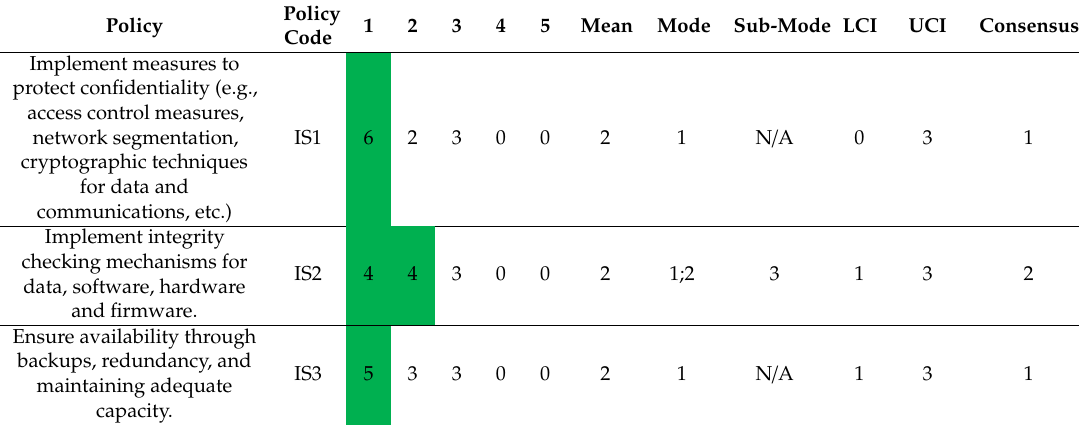
Table 20. Information security policies’ starting maturity.